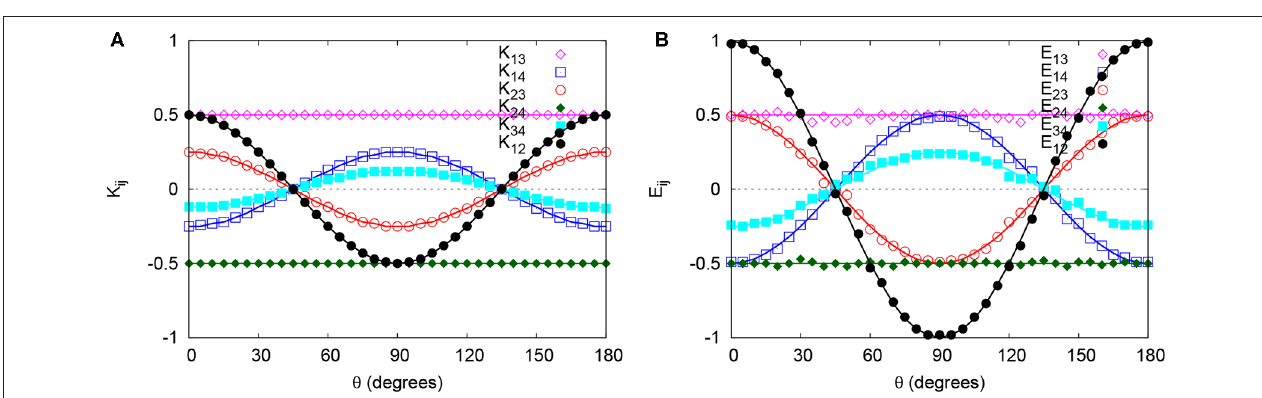
a b , with b a π/ 6, and d π/ 3. The source emits 0, c = − = = + = K ij [see Equation (7)] predicted by π/ 2); (B) The correlations E ij computed with photon identification b = E ij predicted by quantum theory [solid lines, see Equation (10)] for two spin-1/2 particles in a b